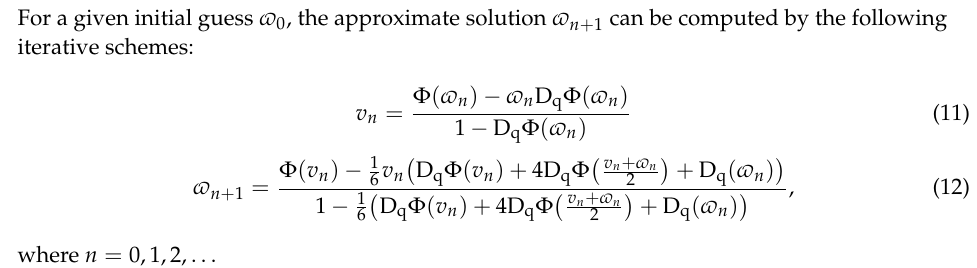
Algorithm 1: q-iterative Scheme of Order